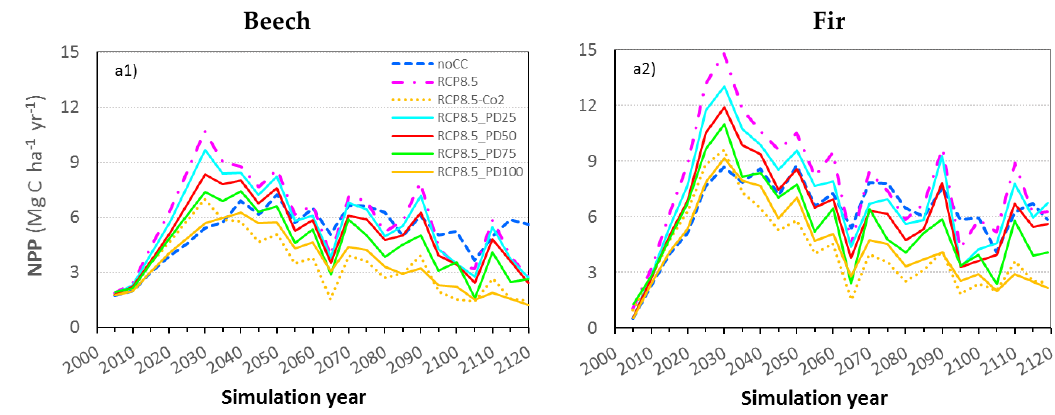
Figure 5. Effects of the climate change scenario RCP8.5 on net primary productivity (NPP) of beech ( a1 ) and fir ( a2 ) with constant CO 2 concentration (370 ppm—global mean of 2000) (RCP8.5-CO 2 ) and with increasing CO 2 concentration assuming photosynthetic downregulation by 25, 50, 75 and 100% (RCP8.5_PD25, RCP8.5_PD50, RCP8.5_PD75, RCP8.5_PD100). Simulations started with a naturally regenerated juvenile stand.